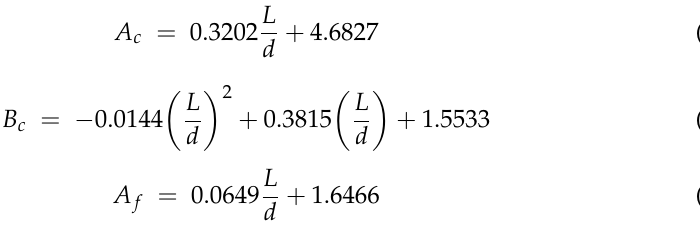
( d ) Figure 13. Failure pattern in the uniaxial compressive test for various bond friction coefficients: ( a ) 𝜇 (cid:3029) = 0 ; ( b ) 𝜇 (cid:3029) = 0.1 ; ( c ) 𝜇 (cid:3029) = 0.2 ; ( d ) 𝜇 (cid:3029) = 0.3 . Figure 14 shows the effect of relative particle size for various bond friction coeffi- cients. The compressive and tensile strengths for the bond friction coefficient increased as the relative particle size increased. As the relative particle size increased, the simulated